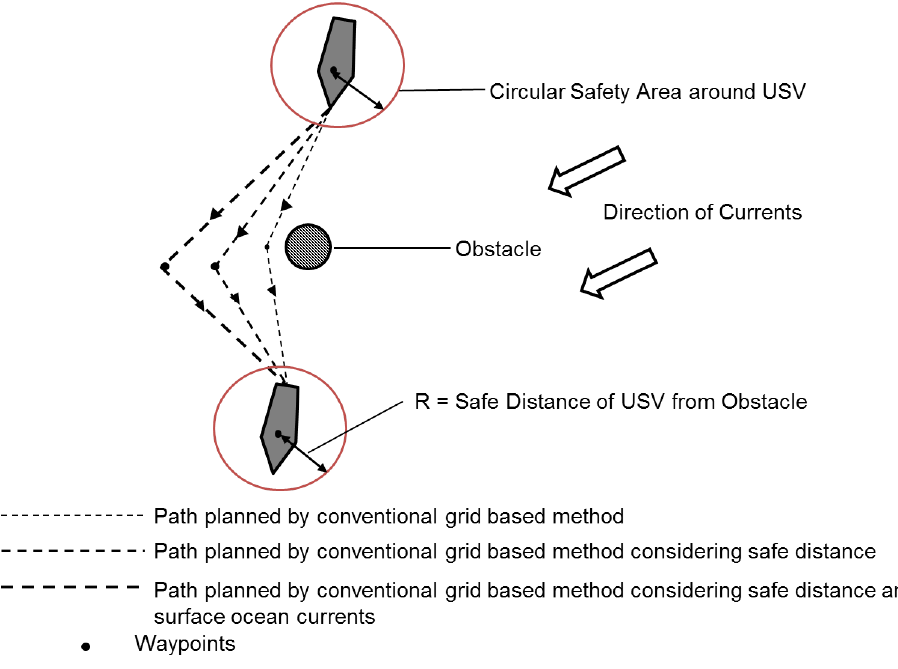
Figure 9. A schematic showing the path generated by a conventional grid based path planner compared against the path generated by a grid based path planner by considering safety distance and sea surface currents (clockwise). In case of anti clockwise currents, the sea surface currents push the USV towards the obstacle and the proposed algorithm makes sure that a safety distance is maintained to ensure no collision [72].